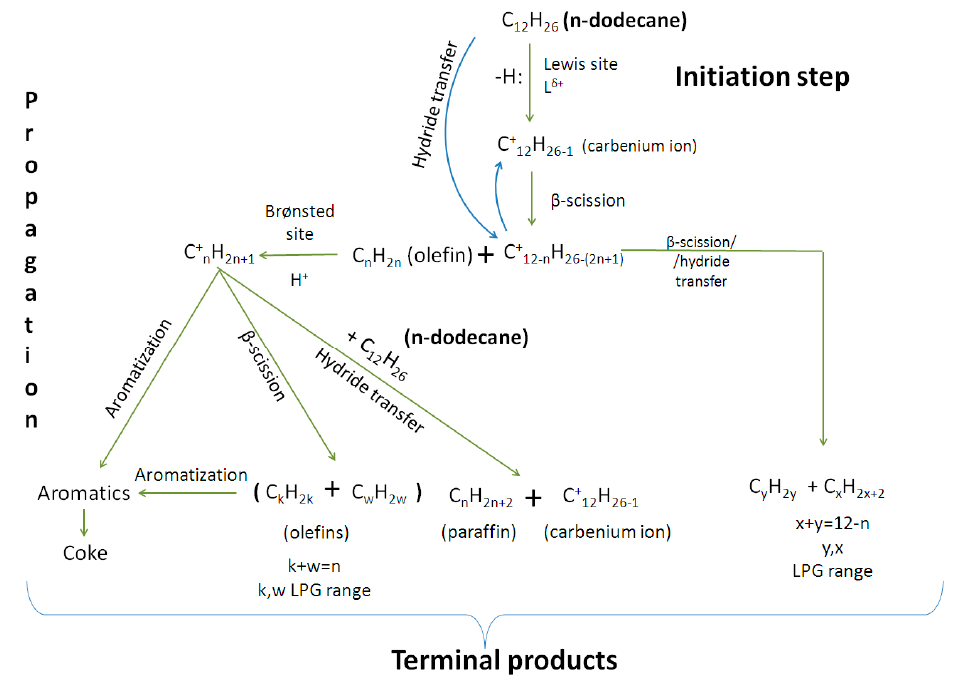
Figure 17. Reactions network for n-C 12 cracking over P/ZSM-5 additives (including SiO 2 /Al 2 O 3 matrix).